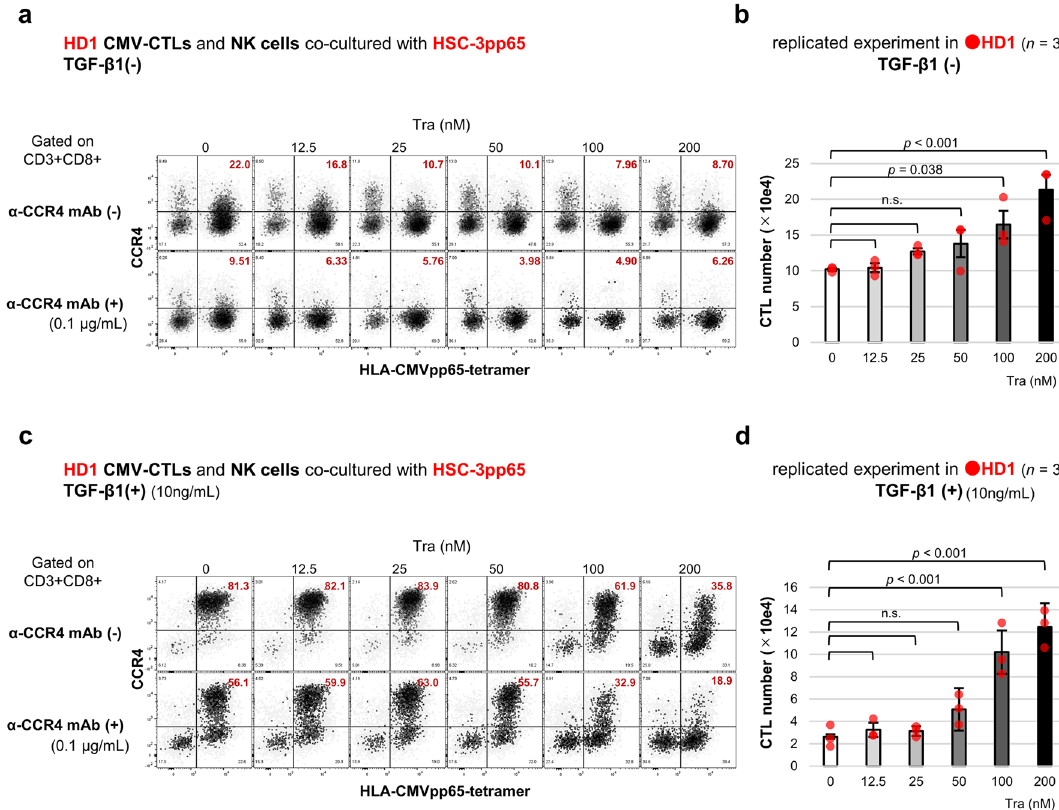
Figure 5. Trametinib alleviated activated CTL reduction by anti-CCR4 mAb. Lymphocytes containing expanded CMV-CTLs and NK cells derived from HD1 were co-cultured with HSC-3pp65 cells for 5 days. 0.1 μg/mL KM2760 and serial concentration of trametinib were supplemented. The results for the groups without TGF-β1 ( a,b ) and with 10 ng/mL TGF-β1 ( c,d ) are shown. HLA-CMVpp65-tetramer and CCR4 expression in CD8 + T-cells were evaluated using flow cytometry and are shown with a representative ( a,c ). The number of CTLs in the group treated with KM2760 is shown with a summary of results ( n = 3, independent replicates) ( b,d ). Error bars indicate standard errors. Statistical analysis was performed using a two-sided Dunnett’s test, and p < 0.05 was considered significant.